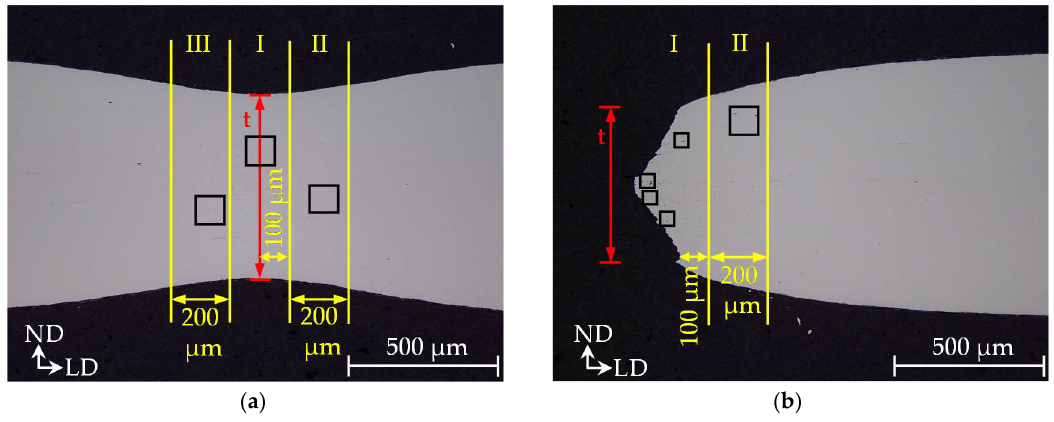
Figure 4. Measurement of porosities: necked specimen ( a ); fractured specimen ( b ).